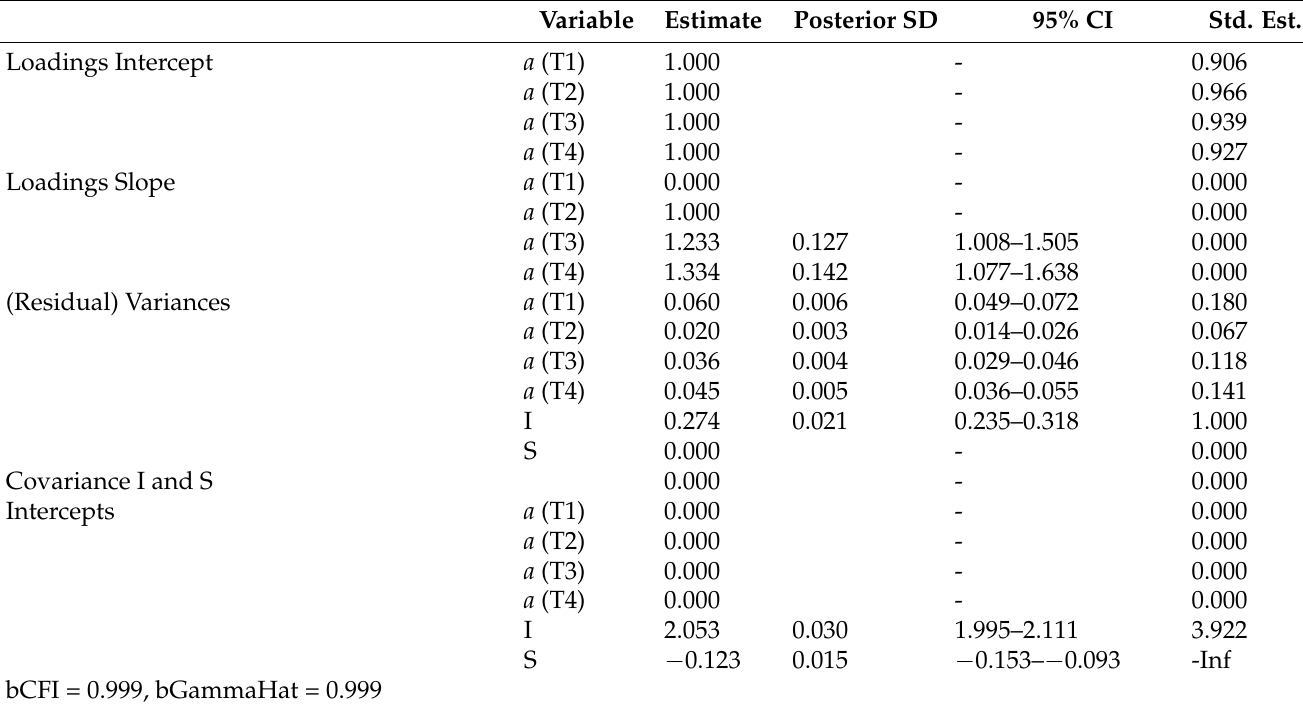
Table 4. Parameter estimates and model fit of the boundary separation growth curve model.